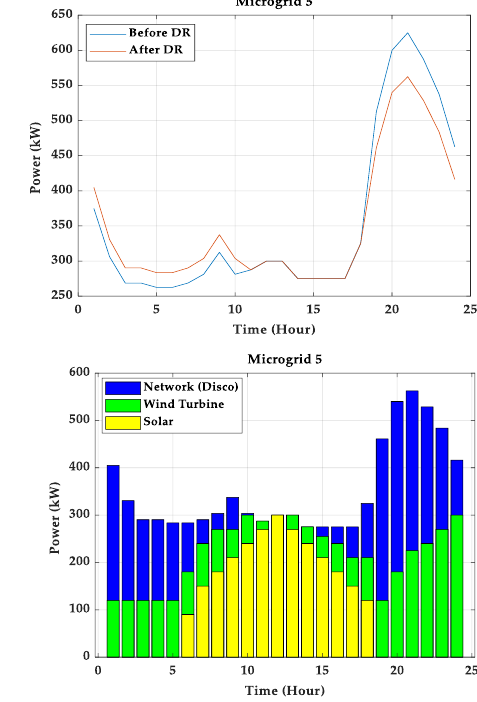
Figure 20. Load curve of MG 6. The overall impact of demand response on the cost and power losses for Case 3 is presented in Figure 21. Figure 21. Overall response of Case 3. 7.4. Case 4: Cost and Loss Calculations with DR and Power-Sharing In the last case, demand response and power-sharing are considered. In this case, the network is considered to be more flexible, as the extra amount of energy in microgrids 0500 1000 15002000